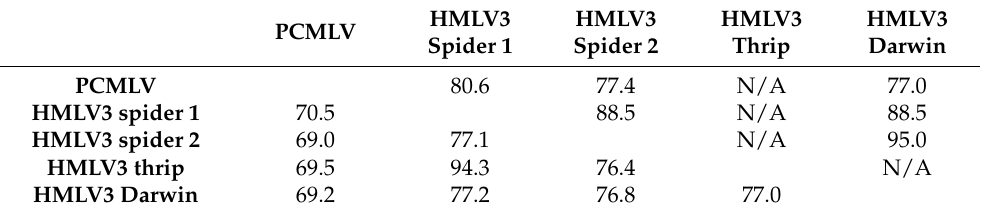
Table 4. Percentage identity between the Australian HMLV3 sequence and other HMLV3 strains and Pyongtaek Culex Macula-like virus. Top right half displays amino acid identities over the coat protein (217 amino acid-long alignment); bottom left half displays nucleotide identities over the whole available sequence (6061 nucleotide-long alignment).